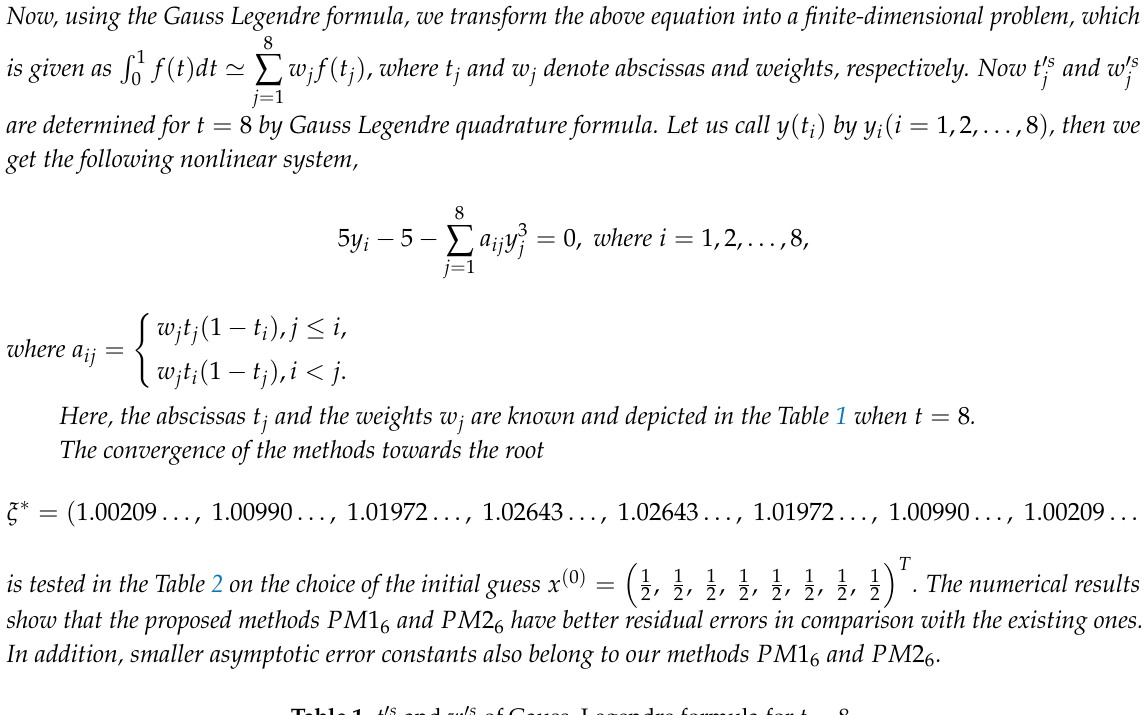
Table 1. t (cid:48) s and w (cid:48) s of Gauss–Legendre formula for t = 8. j j